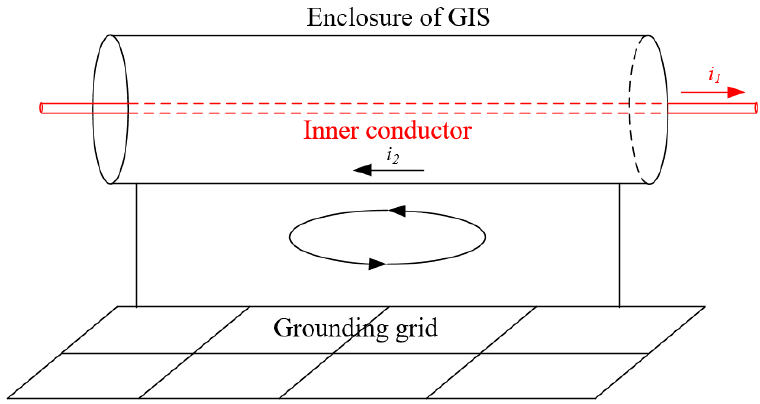
Figure 2. Loop composed of enclosure and grounding grid.